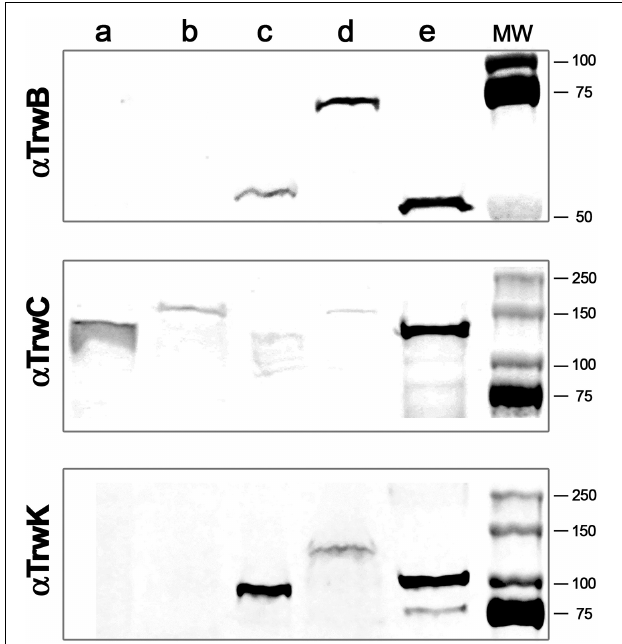
FIGURE 1 | Immunodetection and subcellular localization of conjugative ATPases. MG1655 Escherichia coli cells were transformed with R388 wild type plasmid or with R388 encoding for TrwBmKate2, TrwCmKate2, or TrwKmKate2. Cells were grown to stationary phase and harvested by centrifugation. Cell pellets were re-suspended and lysed by mechanical methods. Soluble and membrane fractions were separated by ultra-centrifugation. Aliquots of each fraction were run in a SDS-PAGE. Gels were transferred to a nitrocellulose membrane and incubated with antibodies anti-TrwB ( upper panel ), anti-TrwC ( middle panel ), or anti-TrwK ( bottom panel ) and then revealed with IRDye. Upper panel : (a) wild type R388 soluble fraction, (b) R388_TrwBmKate2 soluble fraction, (c) wild type R388 membrane fraction, (d) R388_TrwBmKate2 membrane fraction, and (e) purified TrwB (cid:49) N70 protein. Middle panel : (a) wild type R388 soluble fraction, (b) R388_TrwCmKate2 soluble fraction, (c) wild type R388 membrane fraction, (d) R388_TrwCmKate2 membrane fraction, and (e) purified TrwC protein. Bottom panel : (a) wild type R388 soluble fraction, (b) R388_TrwKmKate2 soluble fraction, (c) wild type R388 membrane fraction, (d) R388_TrwKmKate2 membrane fraction, and (e) purified TrwK protein. Estimated MW values for TrwB, TrwBmKate2, and TrwB (cid:49) N70 proteins are 56.3, 82.4, and 48.6 kDa, respectively. Estimated MW values for TrwC and TrwCmKate2 proteins